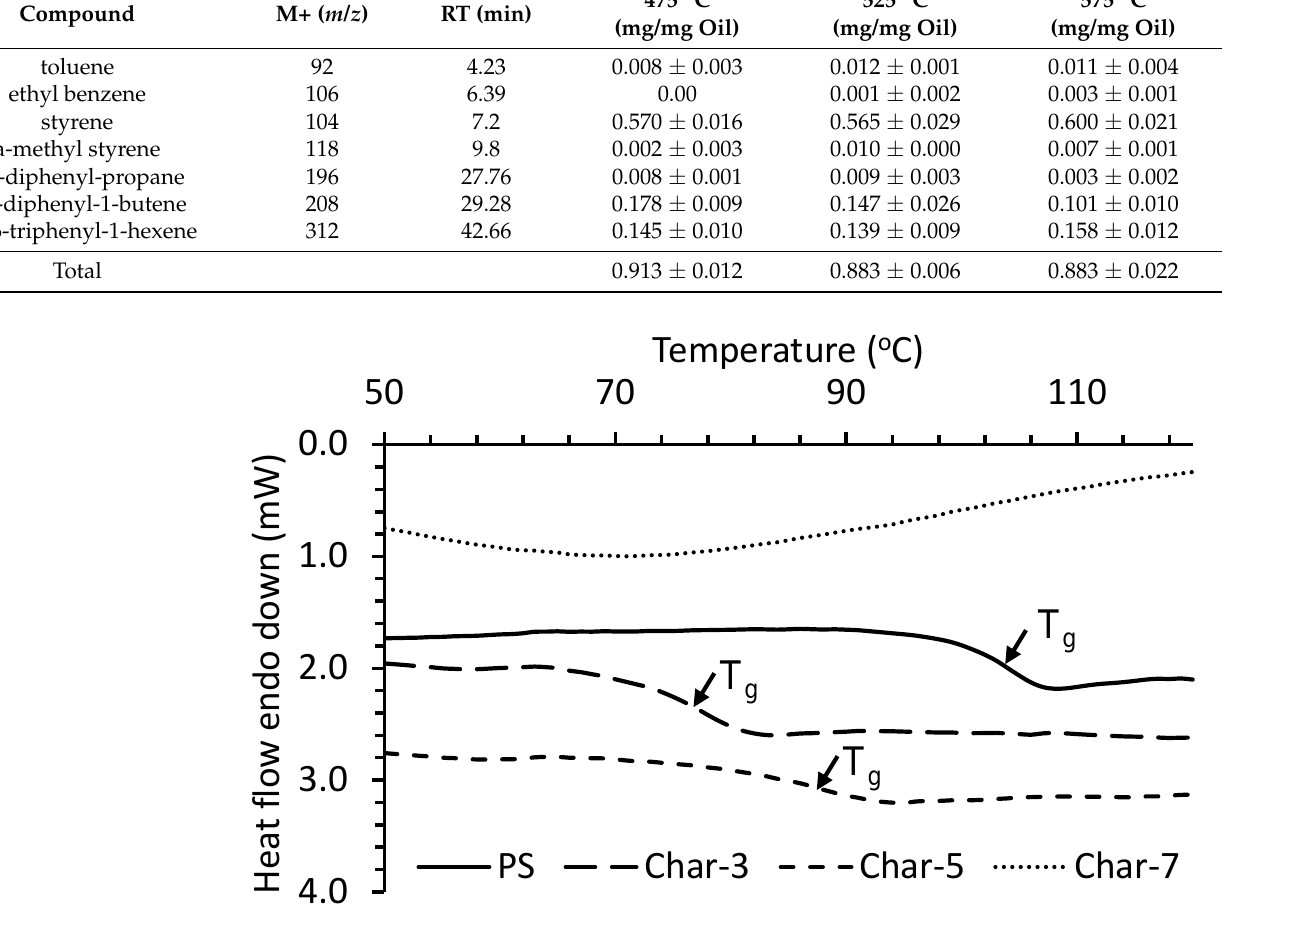
Figure 6. DSC thermograms of PS and char-3, char-5, and char-7.